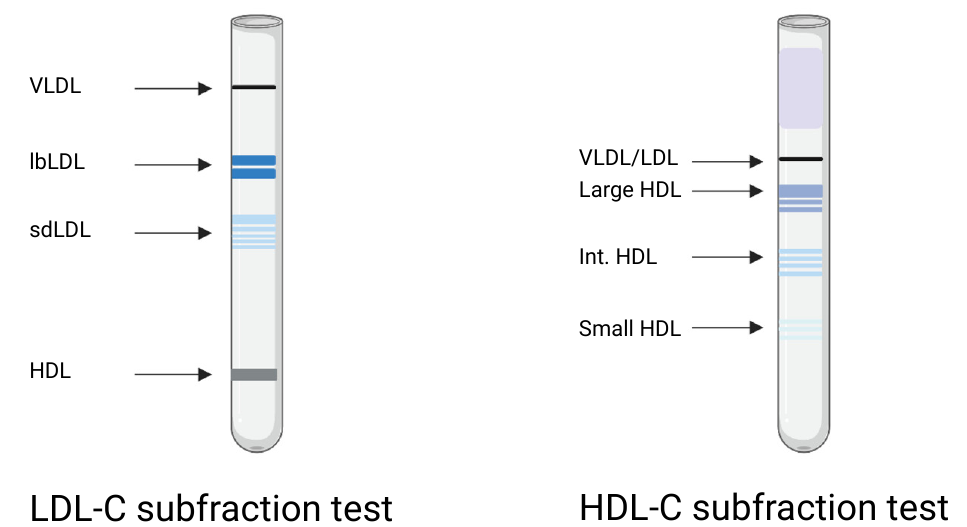
Figure 1. Graphical image of the Lipoprint LDL-C and HDL-C subfraction electrophoresis. VLDL: very low density lipoprotein. lbLDL: large, buoyant low-density lipoprotein cholesterol (LDL-C). sdLDL: small, dense LDL-C. HDL: high-density lipoprotein cholesterol. Int. HDL: intermediate HDL-C. Created with BioRender.com (accessed on 5 July 2022).